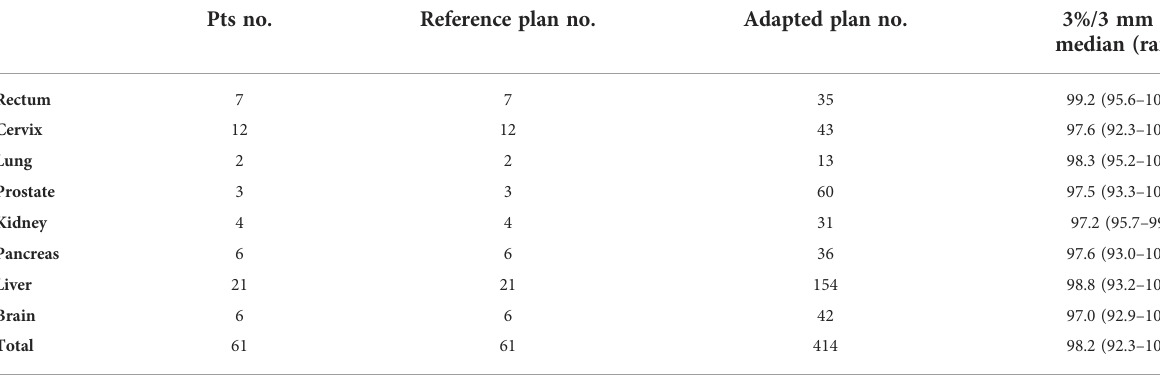
TABLE 2 Quality assurance of treatment plans with ArcCheck: results of gamma analysis of reference and adapted plans. Pts no.